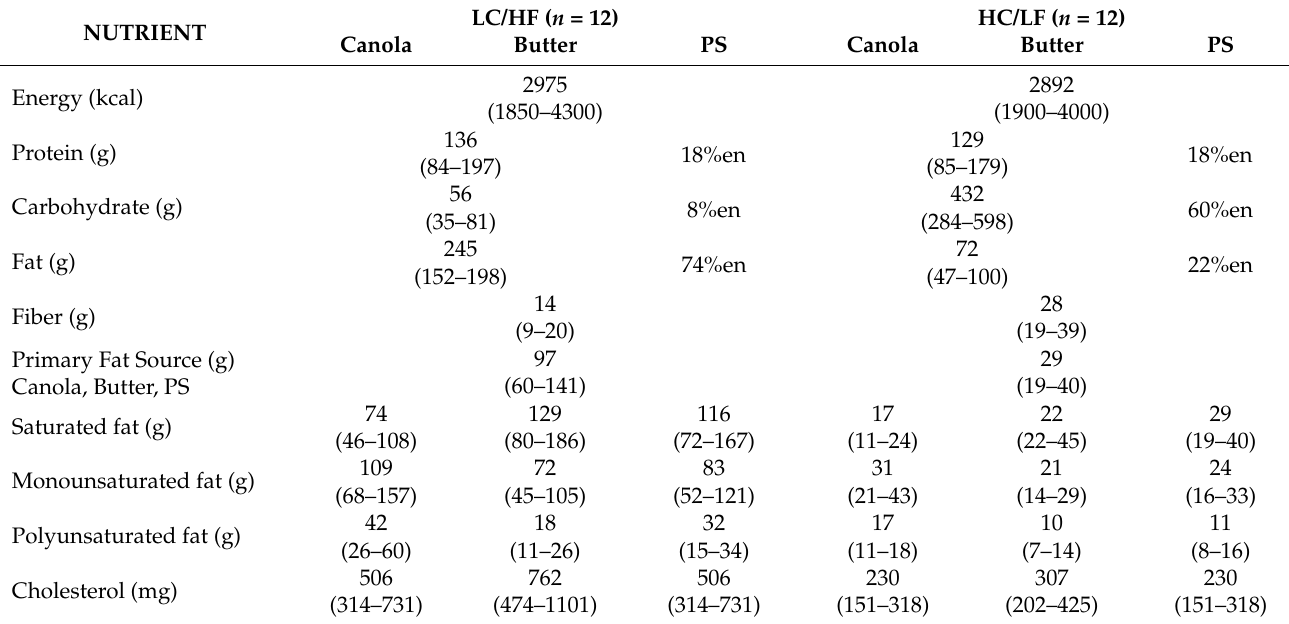
All values reported as Mean (range). Percent energy for each macronutrient is reported as %en. All diets were defined a priori based on diet parameters for each diet period (see methods), but differed between participants based on estimated energy requirements. The primary fats comprised 40% of total